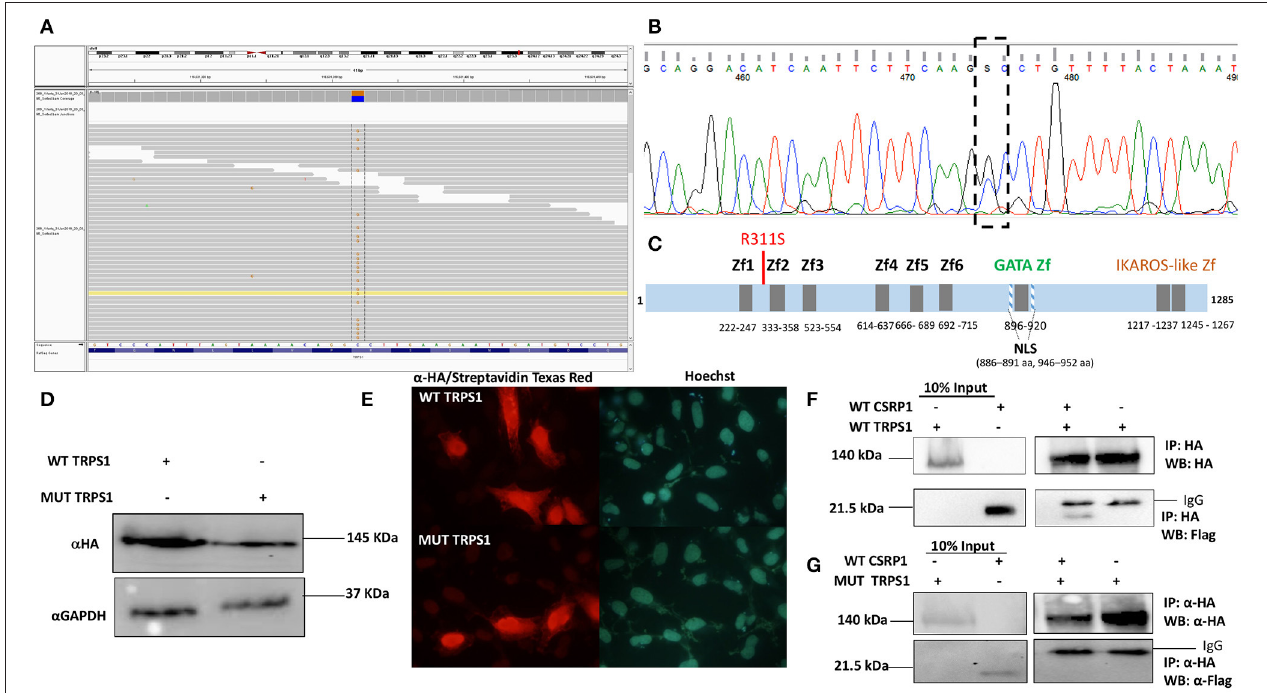
FIGURE 6 | The Physical interaction between TRPS1 and CSRP1. (A) Whole-exome sequencing shows a point mutation [NM_014112.4:c.933G > C] in Trsp1 gene. (B) Sanger sequencing of TRPS1 gene confirms the point mutation G > C in exon 8. (C) Schematic Representation of the TRPS1 protein with the different domains (Zf, Zinc finger; NLS, Nuclear Localization Signal), and the position of the mutation. (D) Nuclear extracts from transfected HEK293 cells with either WT TRPS1 or MUT TRPS1 were resolved on an SDS-PAGE. Immunoblotting using anti-HA antibody showed equal amounts of expressed proteins at 20 µ g. Anti-GAPDH was used as a loading control. (E) Immunofluorescence of Hela cells transfected with WT TRPS1 and MUT TRPS1 plasmids. The localization of TRPS1 was visualized using anti-HA antibody followed by biotinylated anti-Rabbit antibody and then Streptavidin Texas Red for both WT TRPS1 and MUT TRPS1. Nuclei were stained blue with the Hoechst 33342 dye. TRPS1 (WT or MUT) showed cytoplasmic and nuclear localization (Red color). (F) Physical interaction between HA-tagged TRPS1 and Flag-tagged CSRP1 is demonstrated in the lanes of the right panel . The amount of the proteins used for immunoprecipitation was ten times that used in western